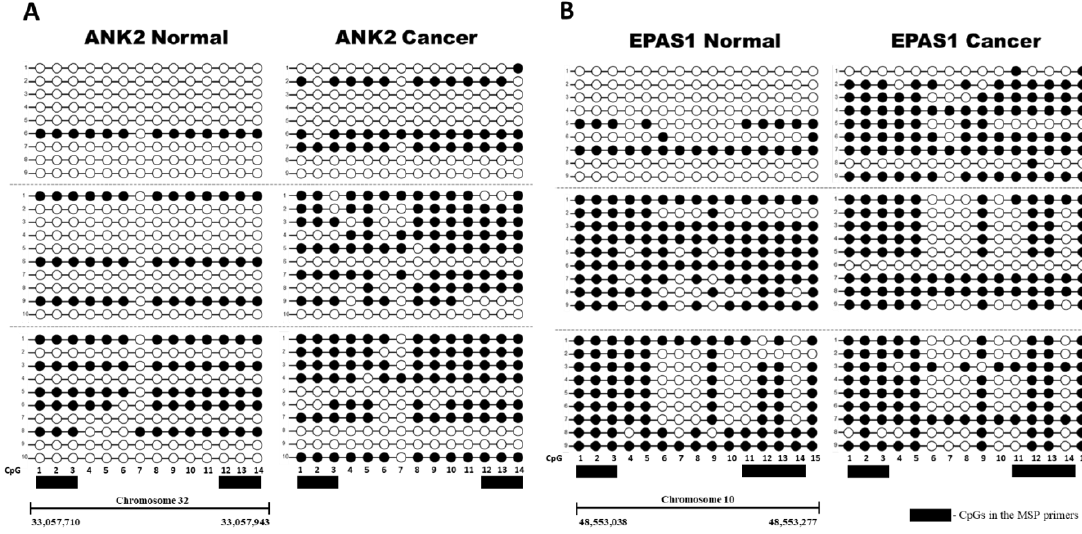
Figure 2. Bisulfite Sequencing PCR (BSP) of ANK2 and EPAS1 . Between 9 and 10 colonies were sequenced for three paired normal and CMT samples (separated by grey dotted line) for ( A ) ANK2 and ( B ) EPAS1 . Methylation of a particular CpG is indicated by a black circle, and non-methylation is indicated by a white circle. The CpGs that were included in the forward and reverse MSP primers for each respective target with a black box.